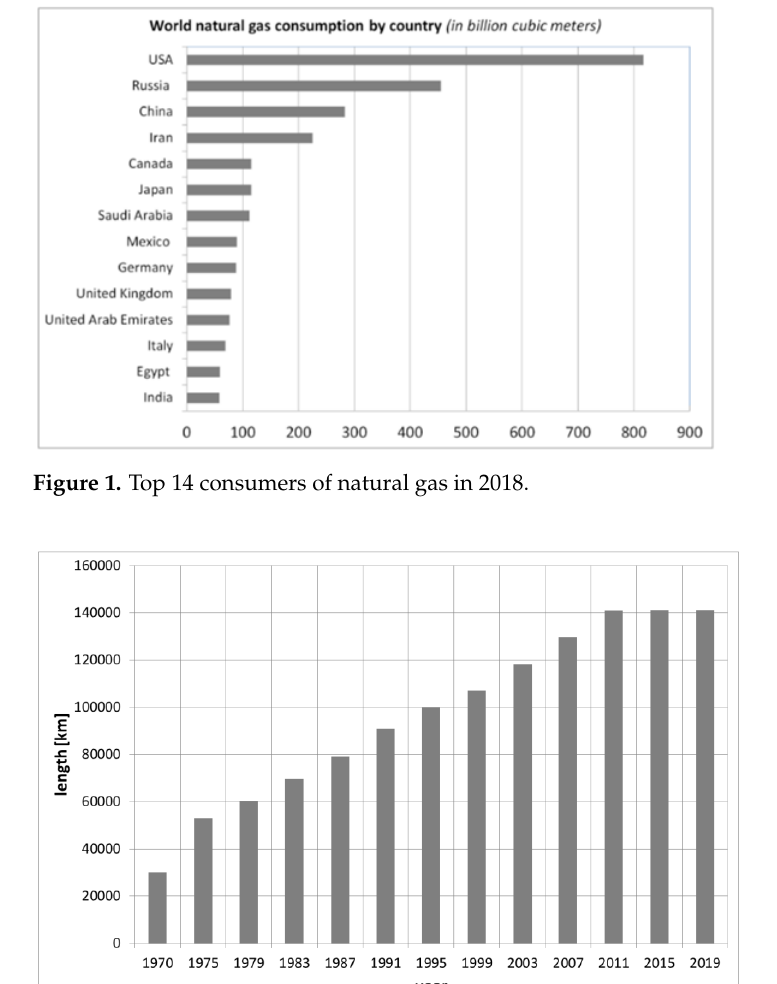
Figure 2. Total length of the European gas transmission system in the EGIG in 2019.